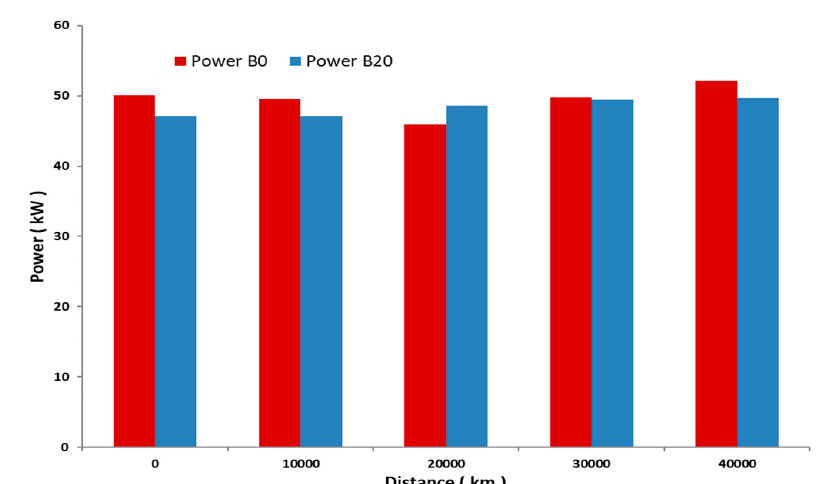
Figure 6. Power curves for B0 and B20.